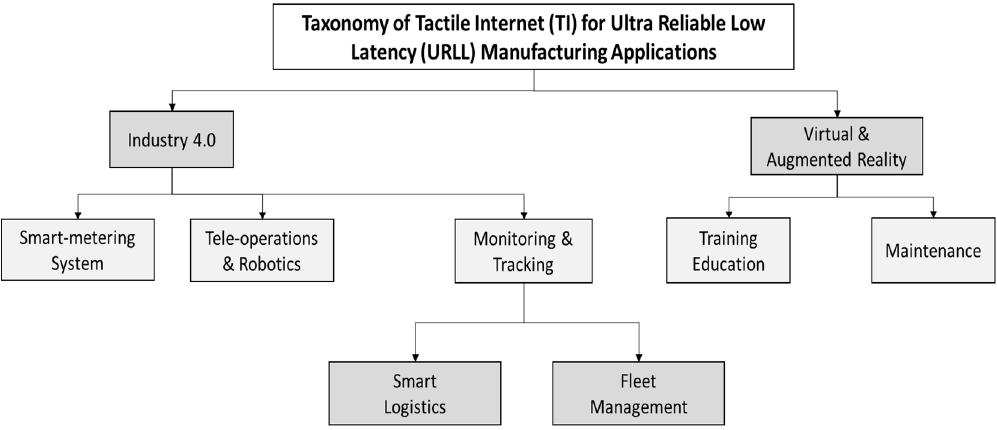
Figure 11. Taxonomy of TI for URLL MFG applications (adapted from [8]).